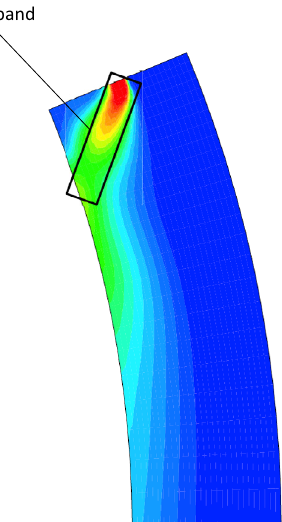
Fig. 7. Location where the average plastic hoop strain in the 45 ° band is calculated.